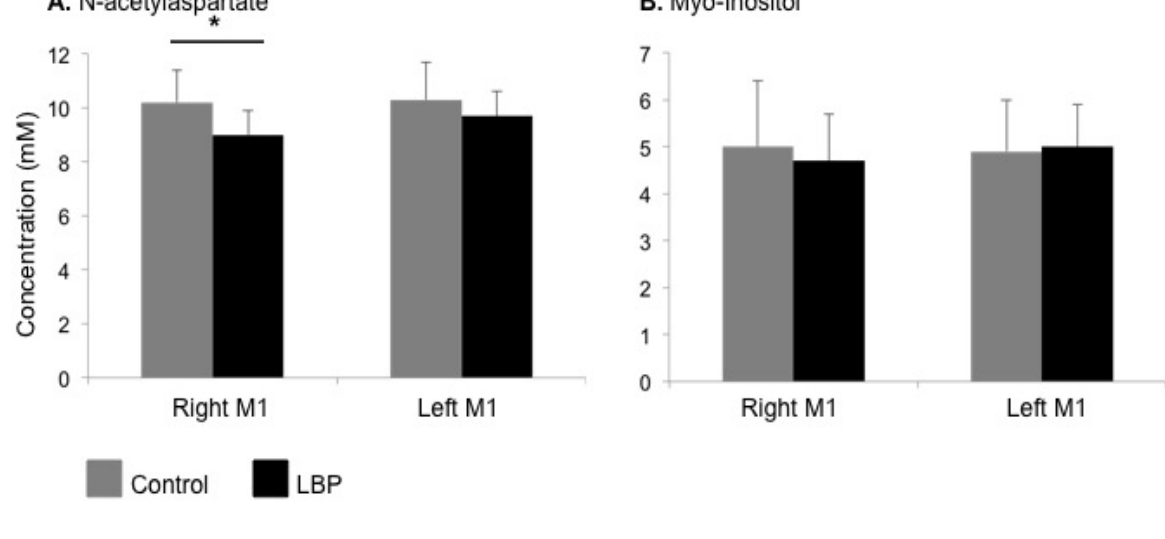
Figure 2. Mean (+SD) concentrations of N -acetylaspartate ( A ) and myo-inositol ( B ) in control (grey bars) and low back pain (LBP, black bars) groups in right and left M1. Significantly lower NAA has been observed in right M1 in LBP; * p < 0.05.